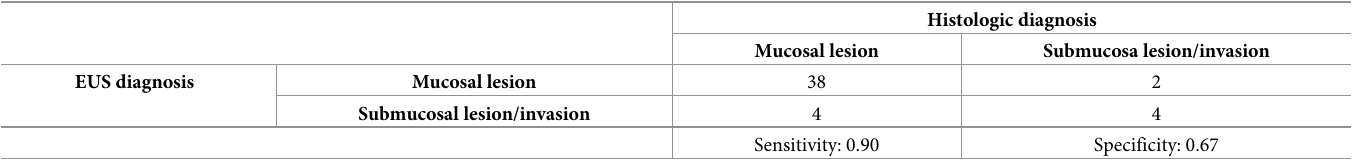
Table 6. The accuracy of